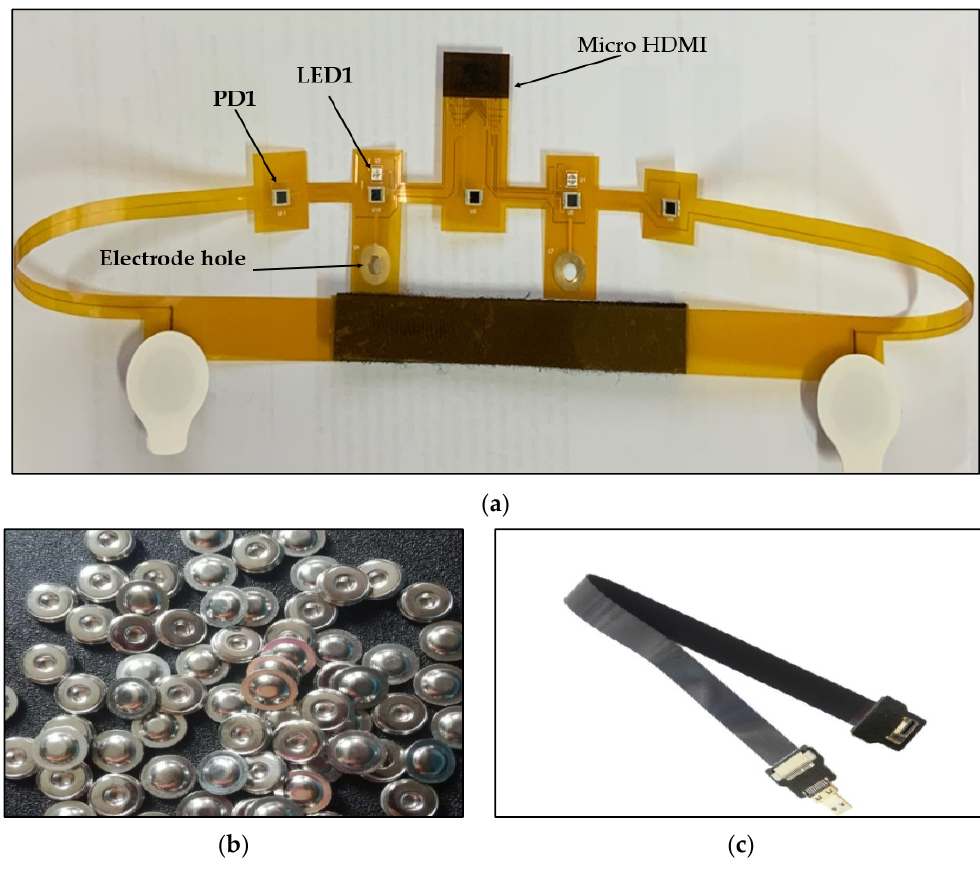
Figure 3. ( a ) Flexible EEG/fNIRS probe, ( b ) 4 mm buckle, ( c ) micro HDMI FPC flat